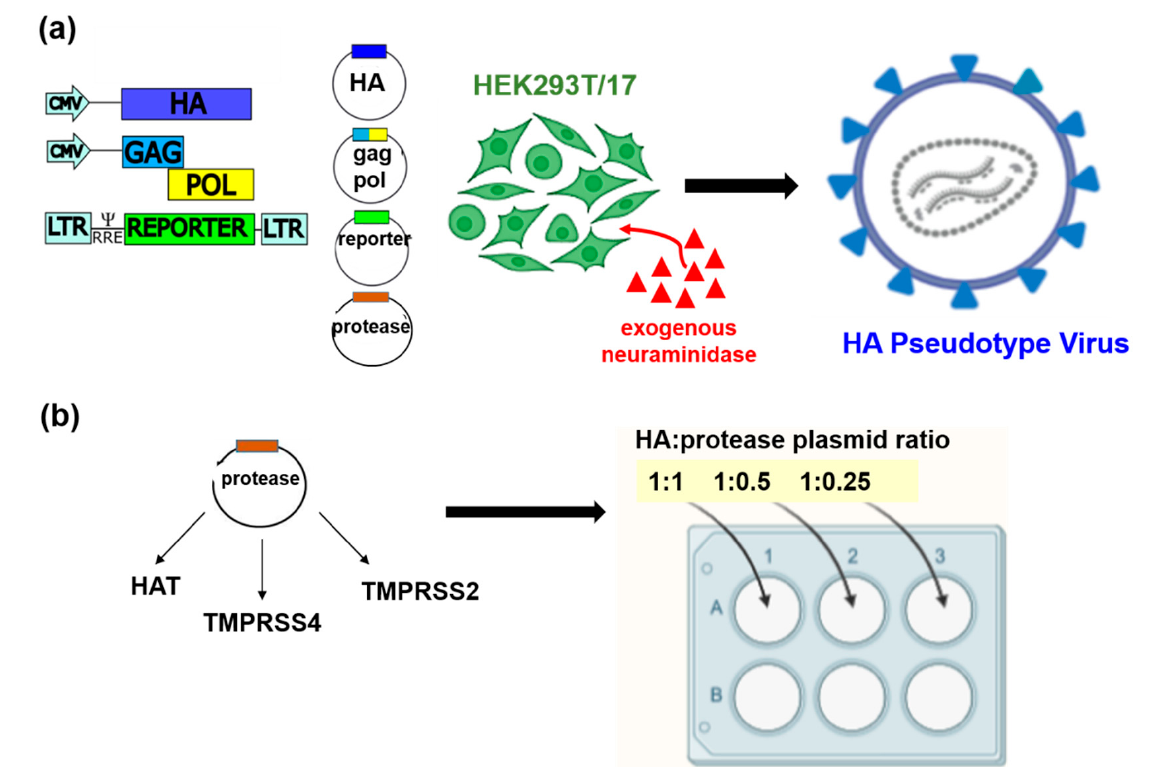
Figure 2. Schematic representation of the production of influenza HA pseudotypes by plasmid transfection. ( a ) Using the 3 or 4 plasmid system, exogenous NA was added to the transfected cultures at least 8 h post-transfection. ( b ) Addition of protease, which is necessary for the production of low pathogenic influenza A viruses (LPAI) and subtypes with a monobasic cleavage site, and IBV were optimized to increase titres by transfecting in a ‘checkerboard’ approach with different proteases (e.g., HAT, TMPRSS4, and TMPRSS2). Protease plasmid was added at a ratio of 1:1, 1:0.5, and 1:0.25 to HA plasmid DNA for rapid optimization in a 6 well plate format. All pseudotypes were harvested after 48 h in culture. The image was created using BioRender. (biorender.com)